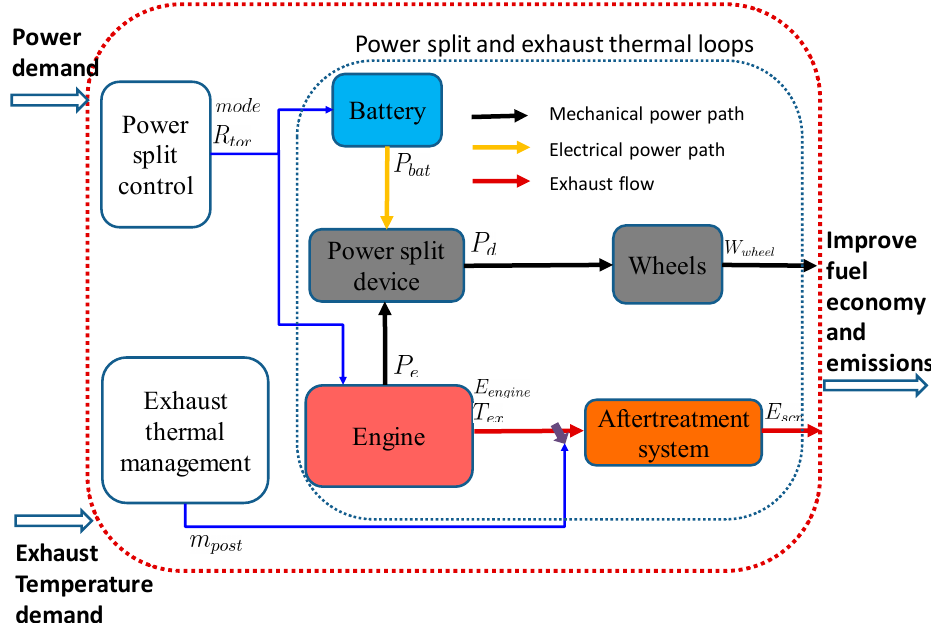
Figure 1. Schematic of the problem statement of the power split and exhaust thermal management.